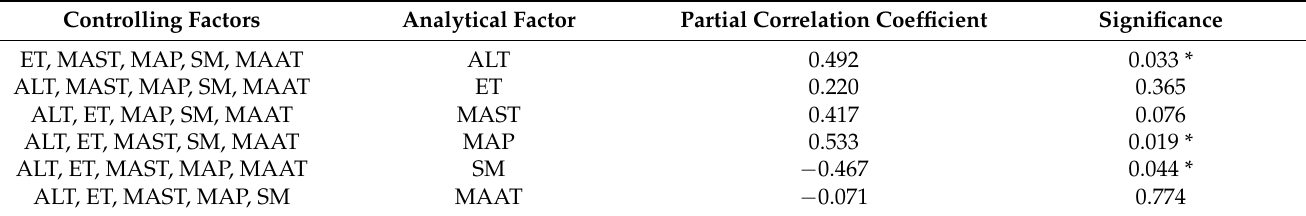
Table 7. The partial correlation analysis between lake area and driving